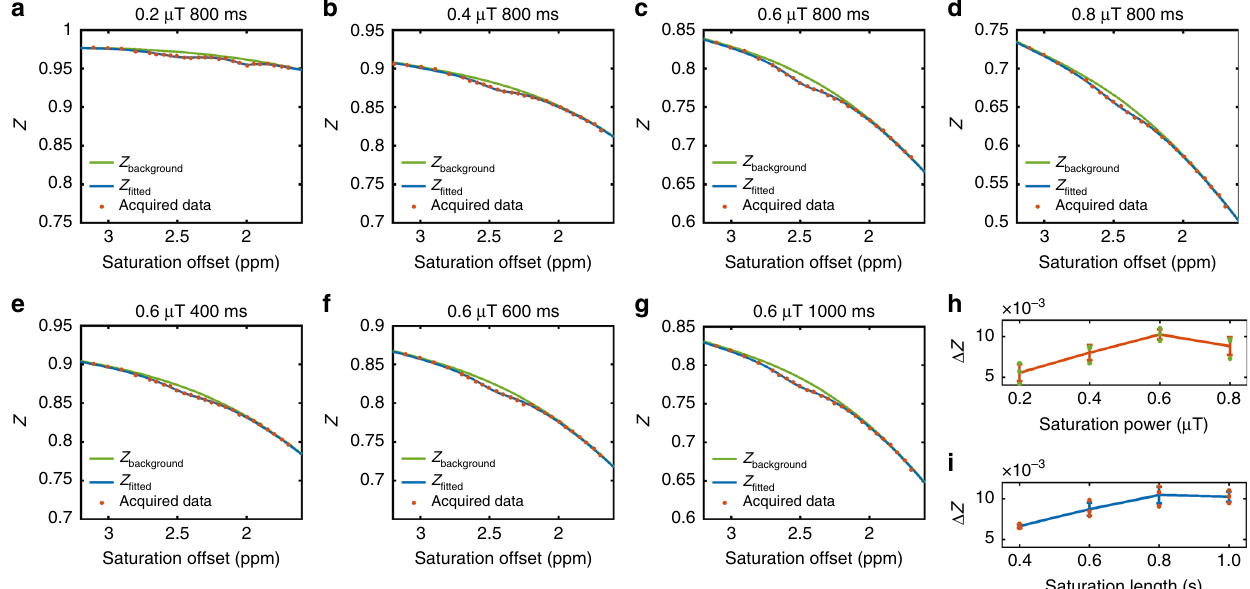
Fig. 3 Optimization of PCr CEST contrast in human skeletal muscle on a 3 T clinical scanner. The Z spectra were fi tted using a polynomial and Lorentzian line-shape fi tting (PLOF) CEST method. The observed CEST signal ( Δ Z) indicating the difference between CEST peak and fi tted background at 2.5 ppm is used as the evaluation parameter. a – d Acquired data and fi tted results of CEST experiments with fi xed saturation length of 800 ms and four saturation powers. e , f Acquired data and fi tted results of CEST experiments with fi xed saturation power of 0.6 µ T and different saturation lengths. h , i Quantitative analysis of Δ Z with different saturation powers and saturation lengths, respectively ( n = 3 ROIs). Error bars show standard deviations in ROIs.